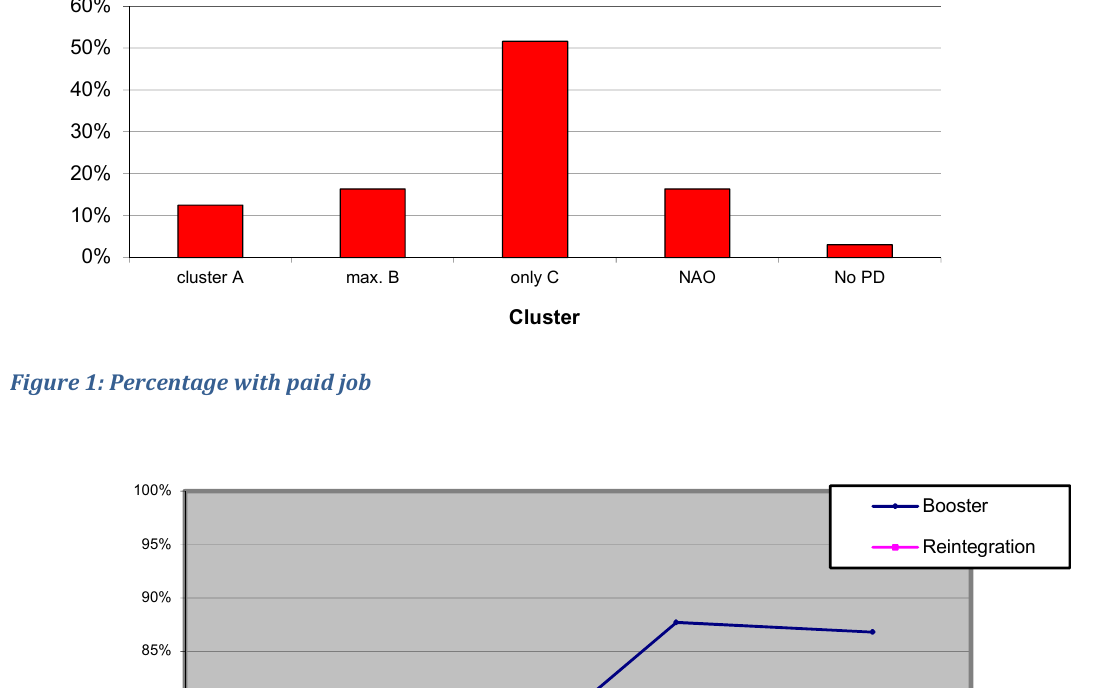
Table 1: Response on the questionnaires